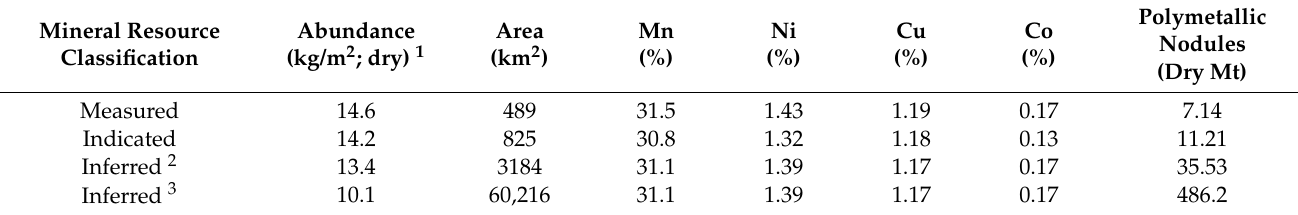
Table 12. Mineral resource estimate for Area